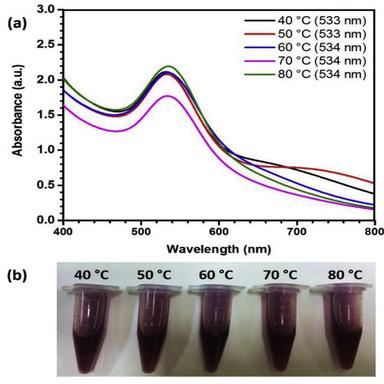
(a) UV–vis spectra of AuNPs synthesized using Lonicera japonica flower extract at varying reaction temperature (40, 50, 60, 70, and 80 °C) and (b) color changes after 2 min reaction incubation (from left to right: 40, 50, 60, 70, and 80 °C). (For interpretation of the references to color in this figure legend, the reader is referred to the Web version of this article.)